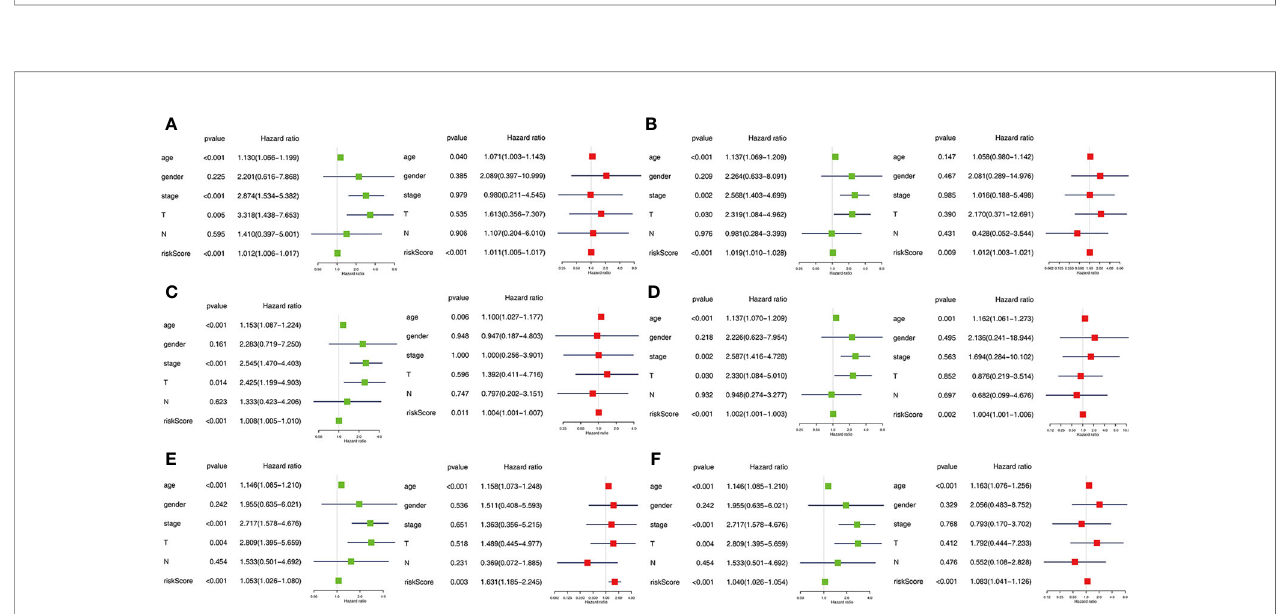
FIGURE 5 | The distribution of risk score (upper panel), the distribution of survival time (middle panel), the expression Heatmap (bottom panel) of six signi fi cant prognostic signatures. AA cohort (A) , AD cohort (B) , AT cohort (C) , ES cohort (D) , ME cohort (E) , the fi nal prediction cohort (F) .